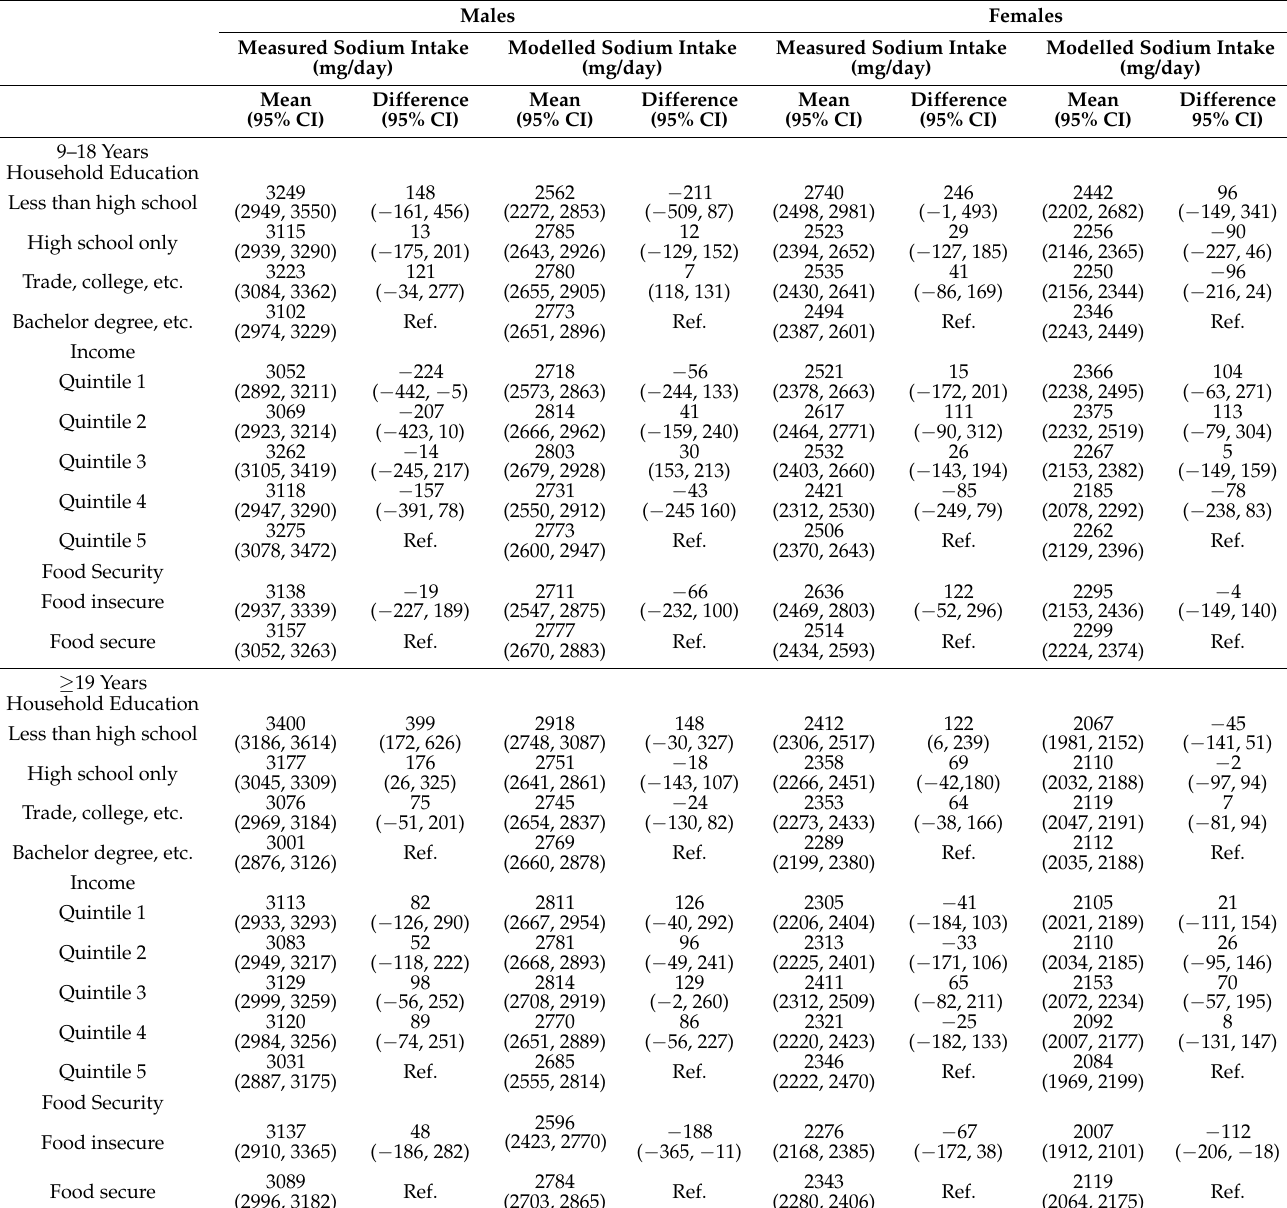
Table 3. Sex-specific adjusted mean sodium intake and mean difference by socioeconomic position as measured and ( n = 3955) and >19 years ( n = 13,519) in the 2015 Canadian Community Health